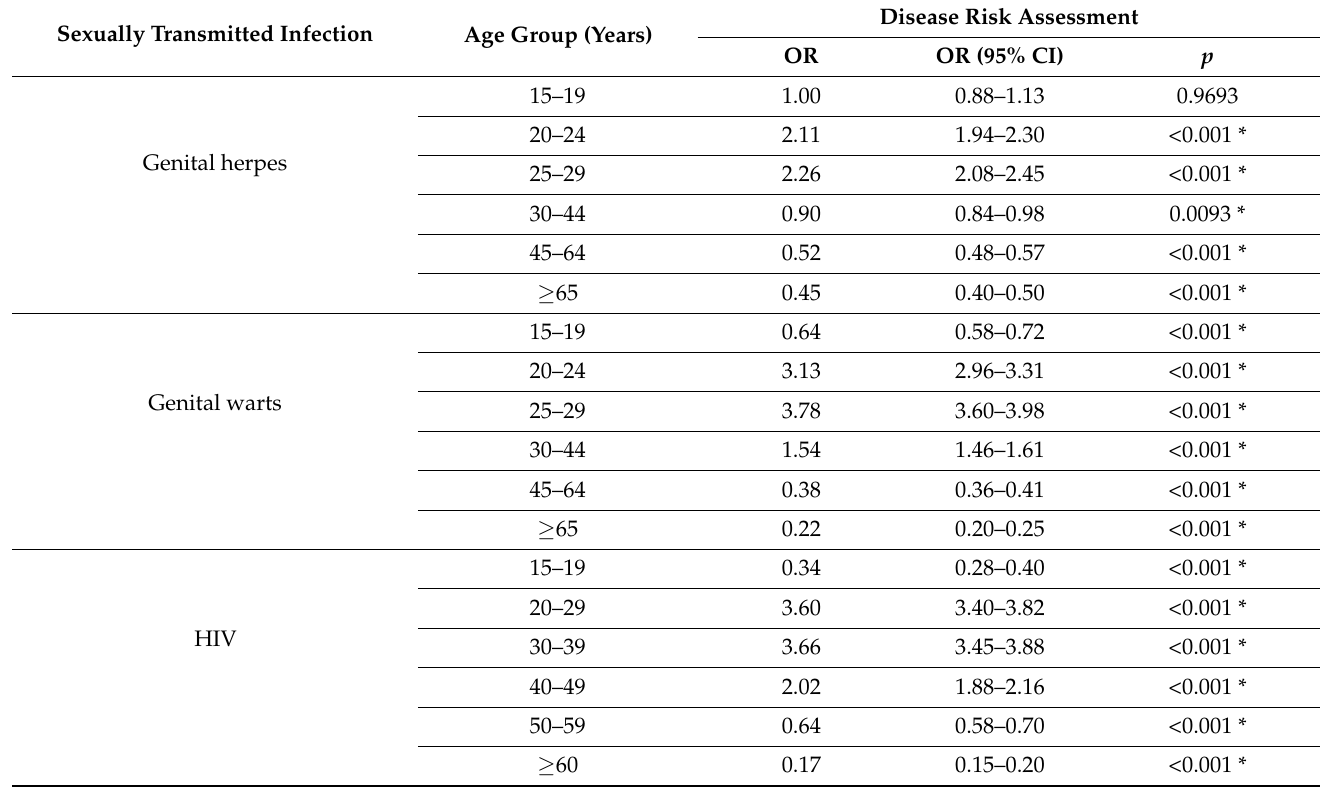
Table 4. Odds ratio of incidence of selected sexually transmitted viral infections by age group.